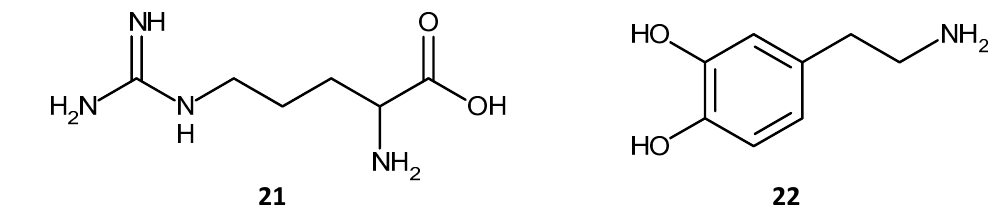
Figure 14. Chemical structures of Arginine ( 21 ) and Dopamine ( 22 ).